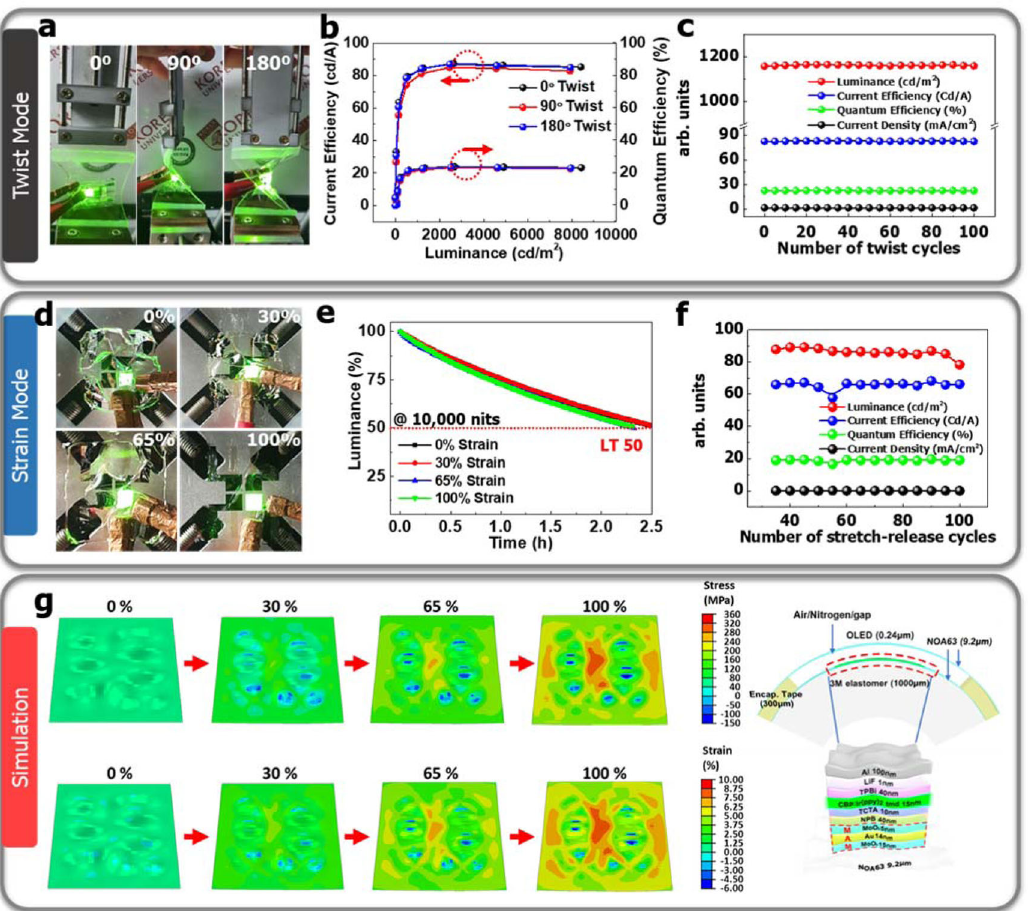
Fig. 4 Device performance of twist mode and strain mode and mechanical simulation of the GSOLED based on 3 M elastomer. a Camera images of the device at different twist angles (0°, 90°, and 180°). b Current ef fi ciency and quantum ef fi ciency at different twist angles. Inset of b shows EL intensity at different twisting angles. c Device performance including luminance (red), current ef fi ciency (blue), quantum ef fi ciency (green), and current density (black) against 100 times twisting cycles. d , Camera images of the device on strain condition (0, 30, 65, and 100%). e Lifetime 50% (LT 50) of the devices at various 2D stretch percentages (0 – 100%). f The device performance stability of the cyclic test was further evaluated using a stretch-release cyclic test where the devices were tested for up to 100 cycles at an applied strain of 30%, demonstrating high mechanical robustness. g Mechanical simulation to demonstrate the strain induced on the GSOLEDs by the wavy buckle formation and schematic illustration showing hollow encapsulation of NOA63 on top of the device